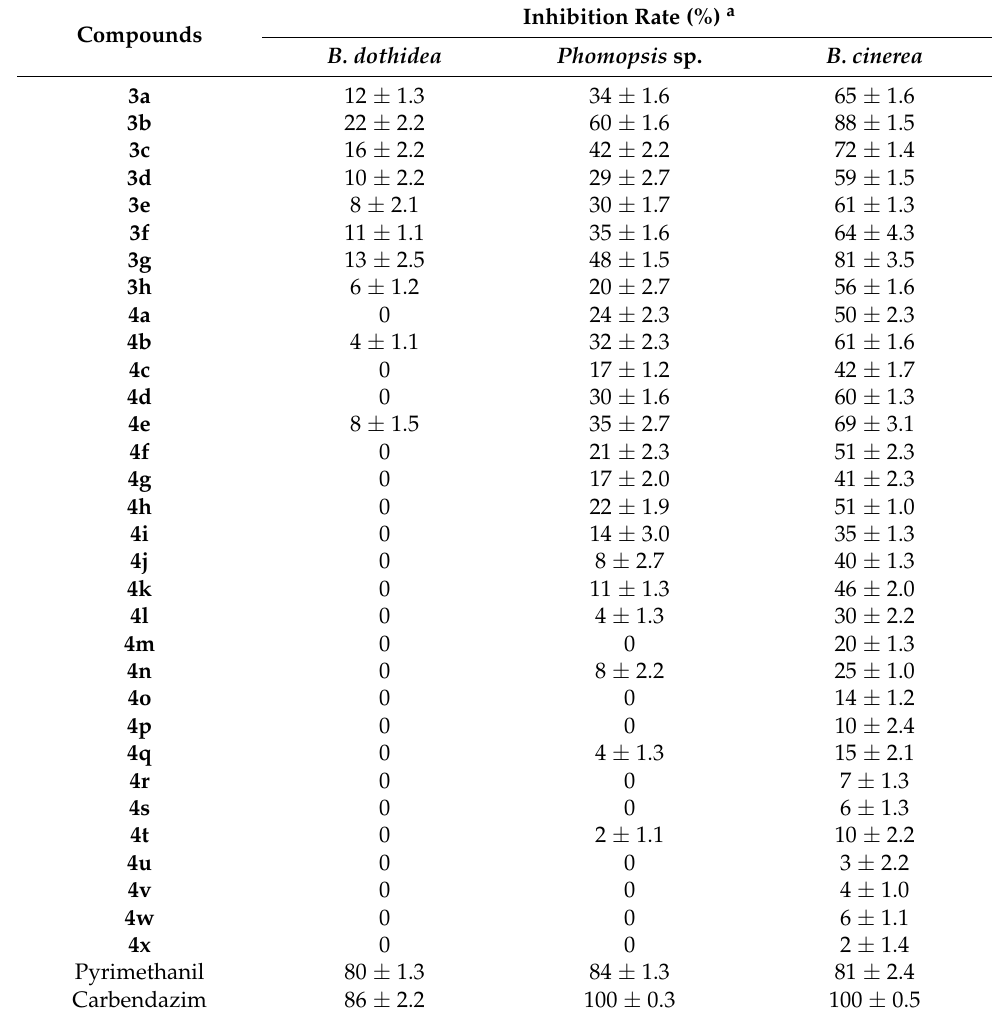
Table 3. In vitro antifungal activities of the target compounds 3a – 3h and 4a – 4x against B. dothidea , Phomopsis sp., and B. cinerea at 50 µ